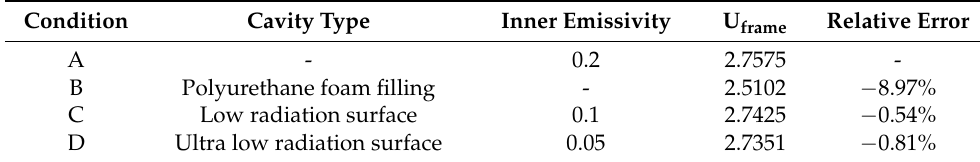
Table 5. Comparative analysis of methods for reducing heat transfer in the